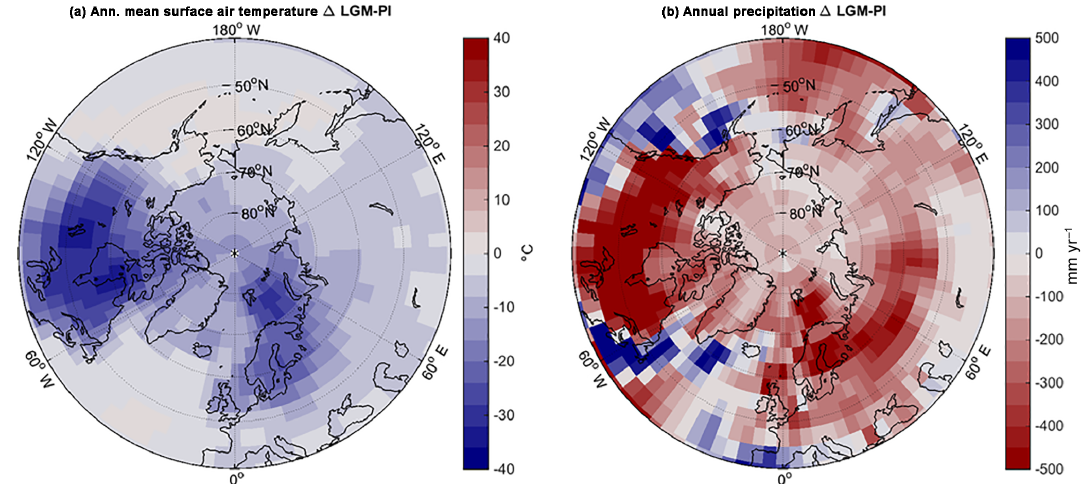
Figure A5. Difference in (a) annual mean surface air temperatures and (b) annual mean precipitation between LGM and PI as simulated by